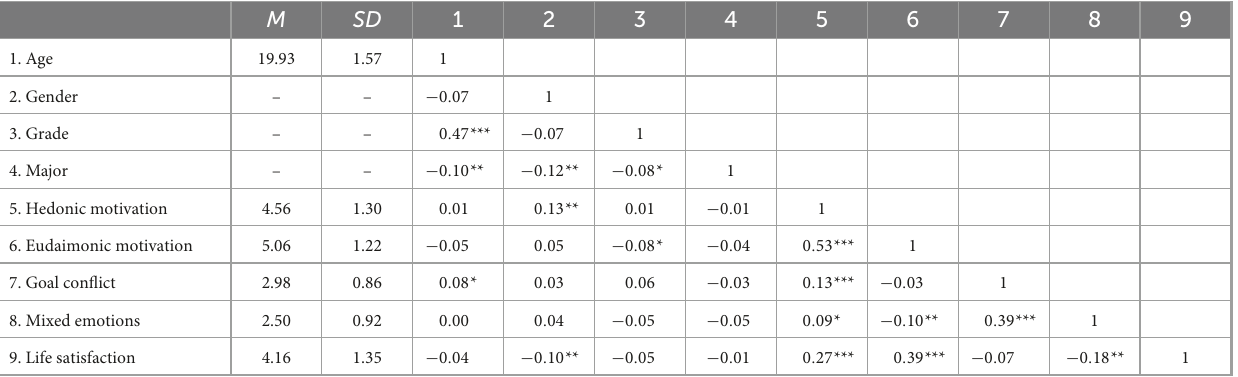
TABLE 1 Descriptive statistics and correlation matrix of each variable ( n =